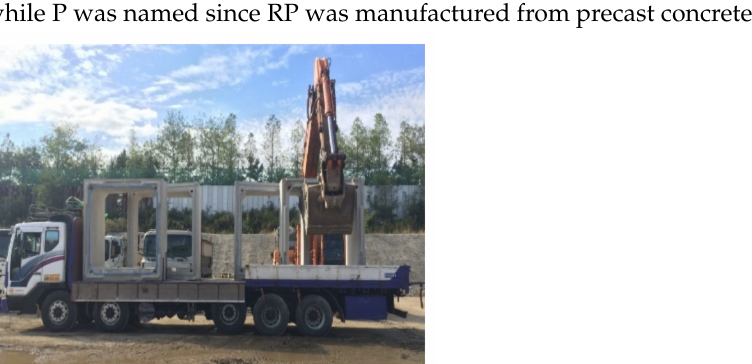
Figure 1. Recycled concrete aggregate (RCA)